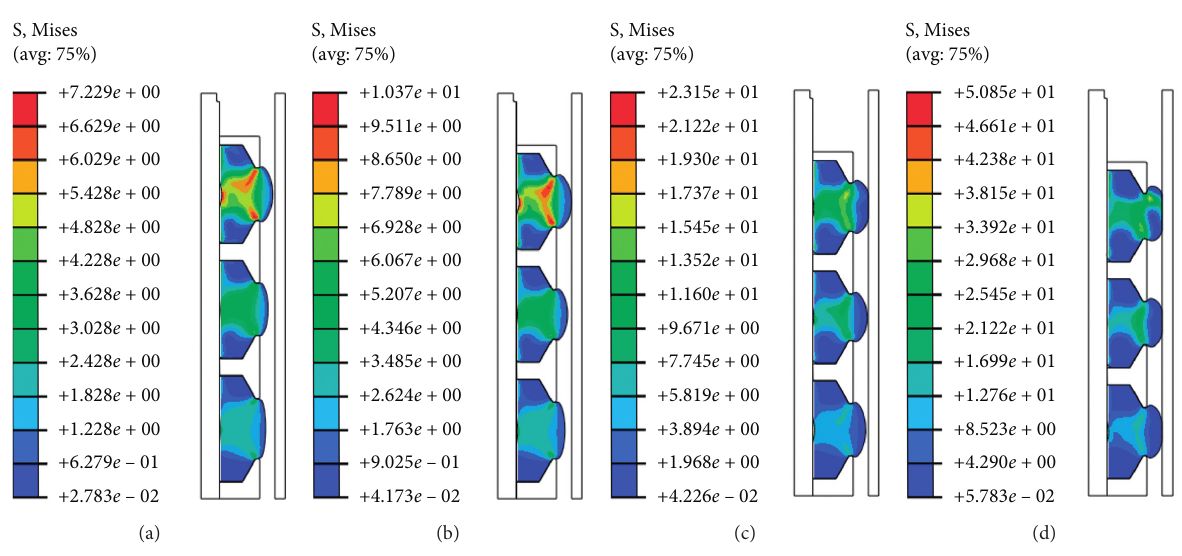
Figure 9: Stress change of the short rubber cylinder at different seating times. (a) t � 3s. (b) t � 5s. (c) t � 7s. (d) t � 9s.